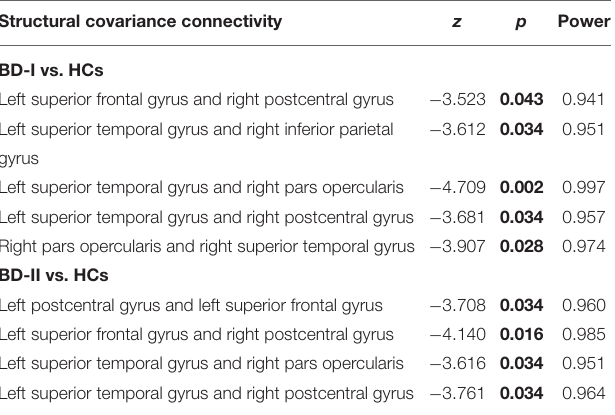
TABLE 3 | Significant between-group differences (BD-I vs. HCs; BD-II vs. HCs) in structural covariance analysis. Structural covariance connectivity z p